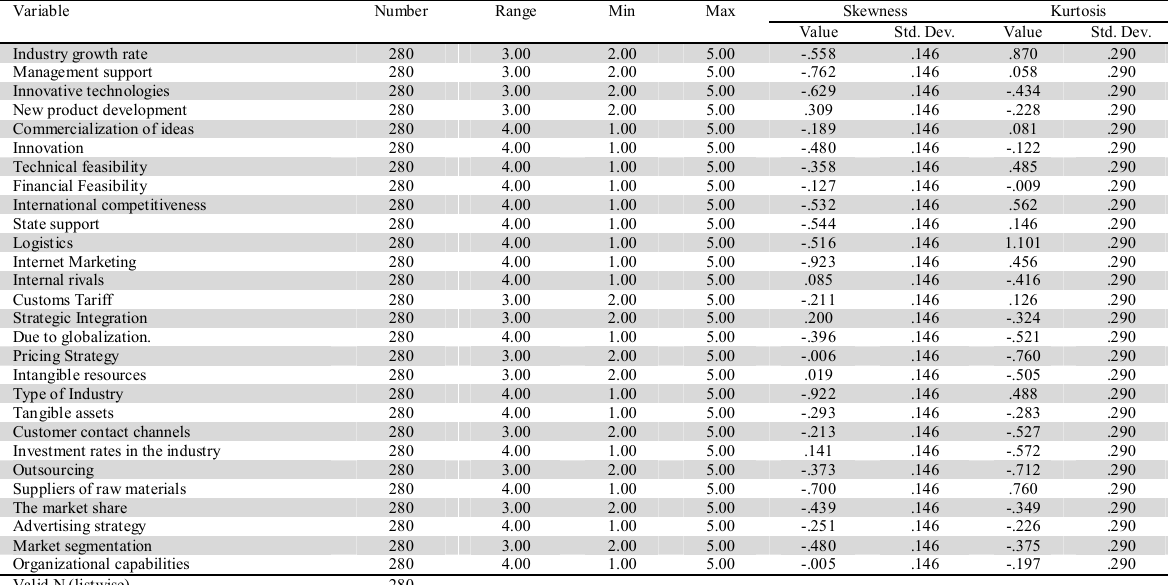
Table 2 The results of some basic statistics Variable